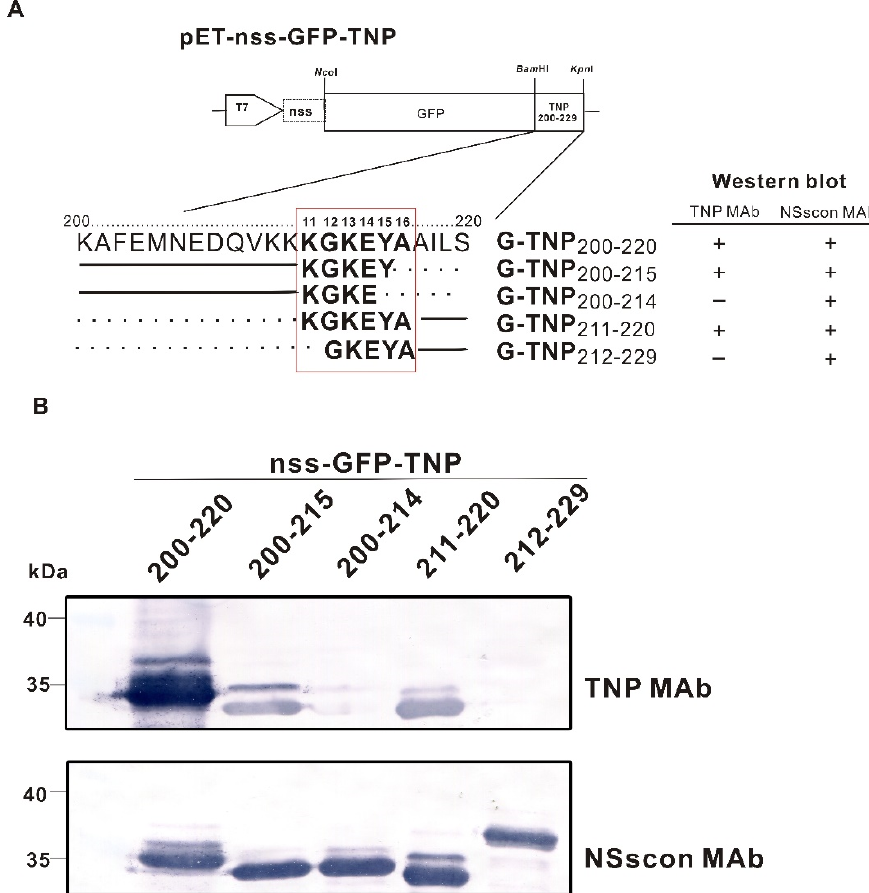
Figure 4. Determination of the core sequence recognized by TNP MAb against the nucleocapsid protein (NP) of the tomato spotted wilt virus (TSWV). ( A ) Constructs of the bacteria-expressing vector pET − nss − GFP − TNP, in which nss − tagged GFP was fused with various deletion sequences of TSWV NP to react with TNP MAb. The numbers indicate the amino acid positions of the NP protein. The solid lines indicate the remaining amino acids of the NP, and the dotted lines indicate the de- leted amino acids. ( B ) Detection of GFPs fused with different lengths of aa 200-229 of NP by western blotting using the TNP MAb (this study) or NSscon MAb [37]. The numbers indicate the aa positions of TSWV NP . All reactions are also indicated in panel ( A ). 2.4. The Feasibility of the np Sequence for Tagging Different Recombinant Proteins in the Bacterial Expression System Because of the high titer and specificity of TNP MAb, the use of the np sequence as an epitope tag for monitoring recombinant proteins was attempted. In addition to GFP, the ZYMV CP [38] and a chimeric dust mite allergen Dp25 [38] were chosen to test the feasibility of tagging with the np sequence and detection by the TNP MAb in the bacterial pETsa system [38]. The expression levels of all the recombinant proteins were comparable, as shown by the western blot assay using the corresponding antibodies against individual proteins (Figure 5A). Our results revealed that the three test proteins fused with the np sequence, either at their N- or C-terminus, were readily detected by the TNP MAb. The sensitivity was comparable to the detection by the nss-tag caught with NSscon MAb [37] (Figure 5B). Remarkably, the intensities of the reaction signals with both TNP MAb and NSscon MAb were even more substantial than the corresponding polyclonal antisera in the bacteria expression system (Figure 5B).